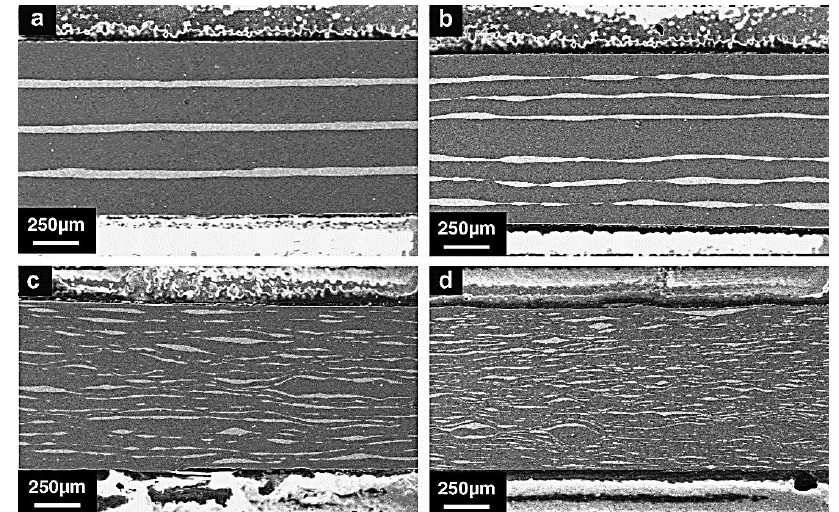
Figure 13. Scanning electron microscope (SEM) micrograph of ARB processed Al/Cu composite cross sections ( a ) primary sandwich, ( b ) 1st cycle, ( c ) 2nd cycle and ( d ) 5th cycle [84].